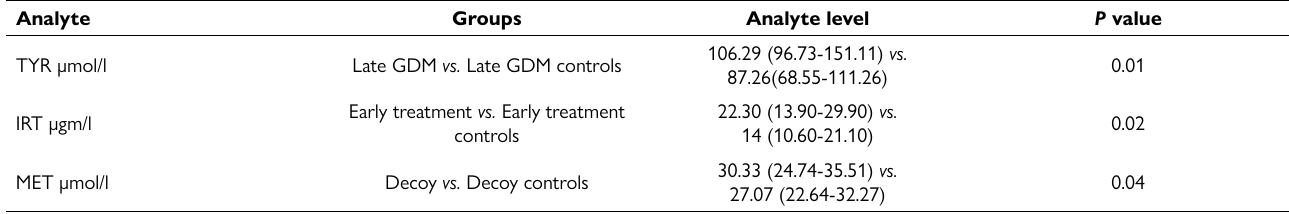
Table 3. Analytes of significance between late GDM and controls, early treatment and controls and decoy groups and controls.